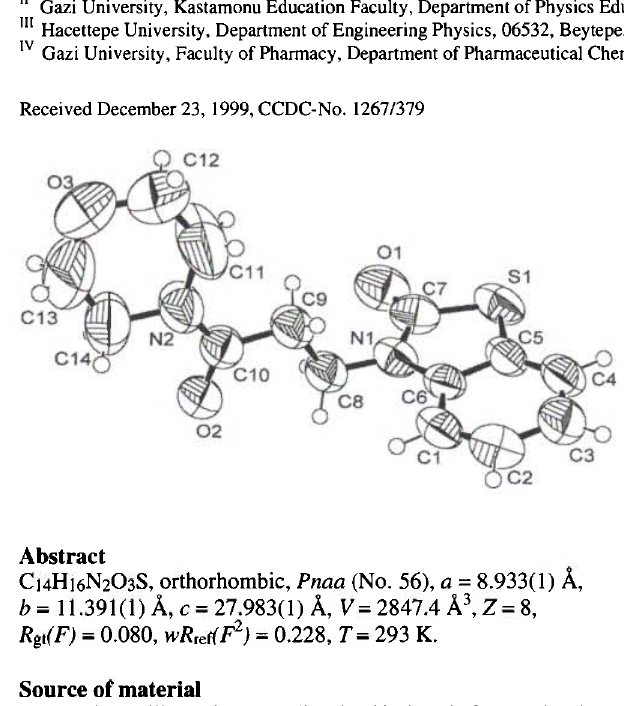
Table 1. Data collection and handling.